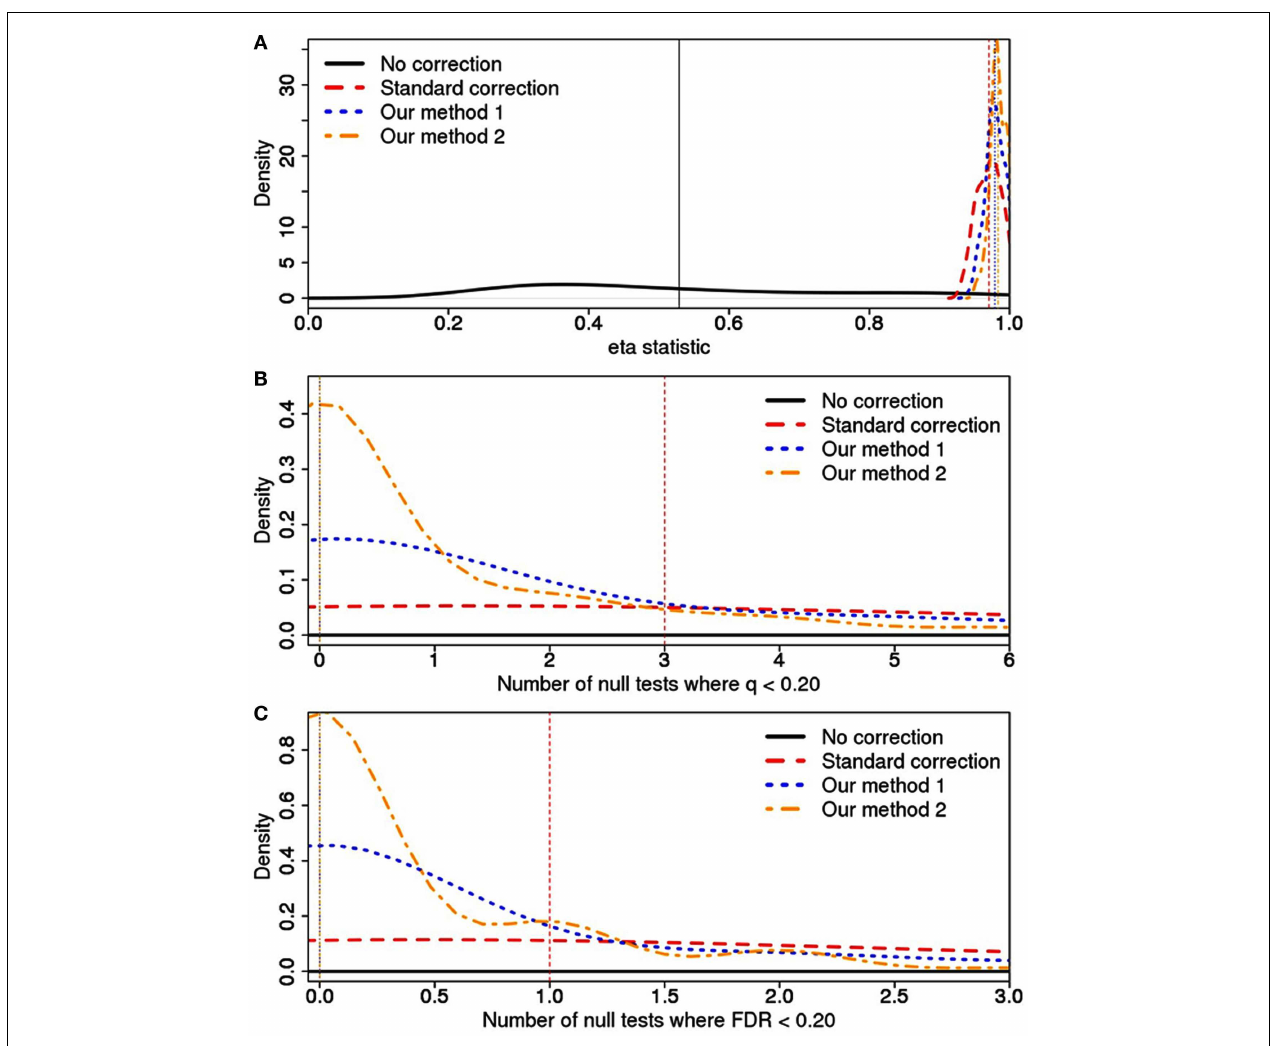
value in plots (B,C) . In (A) , the scale on the x -axis is designed to demonstrate how the various correction methods all vastly outperform the model without any correction. In (B,C) , the x -axis scale has focused in on the three correction methods to better demonstrate the gain resulting from our